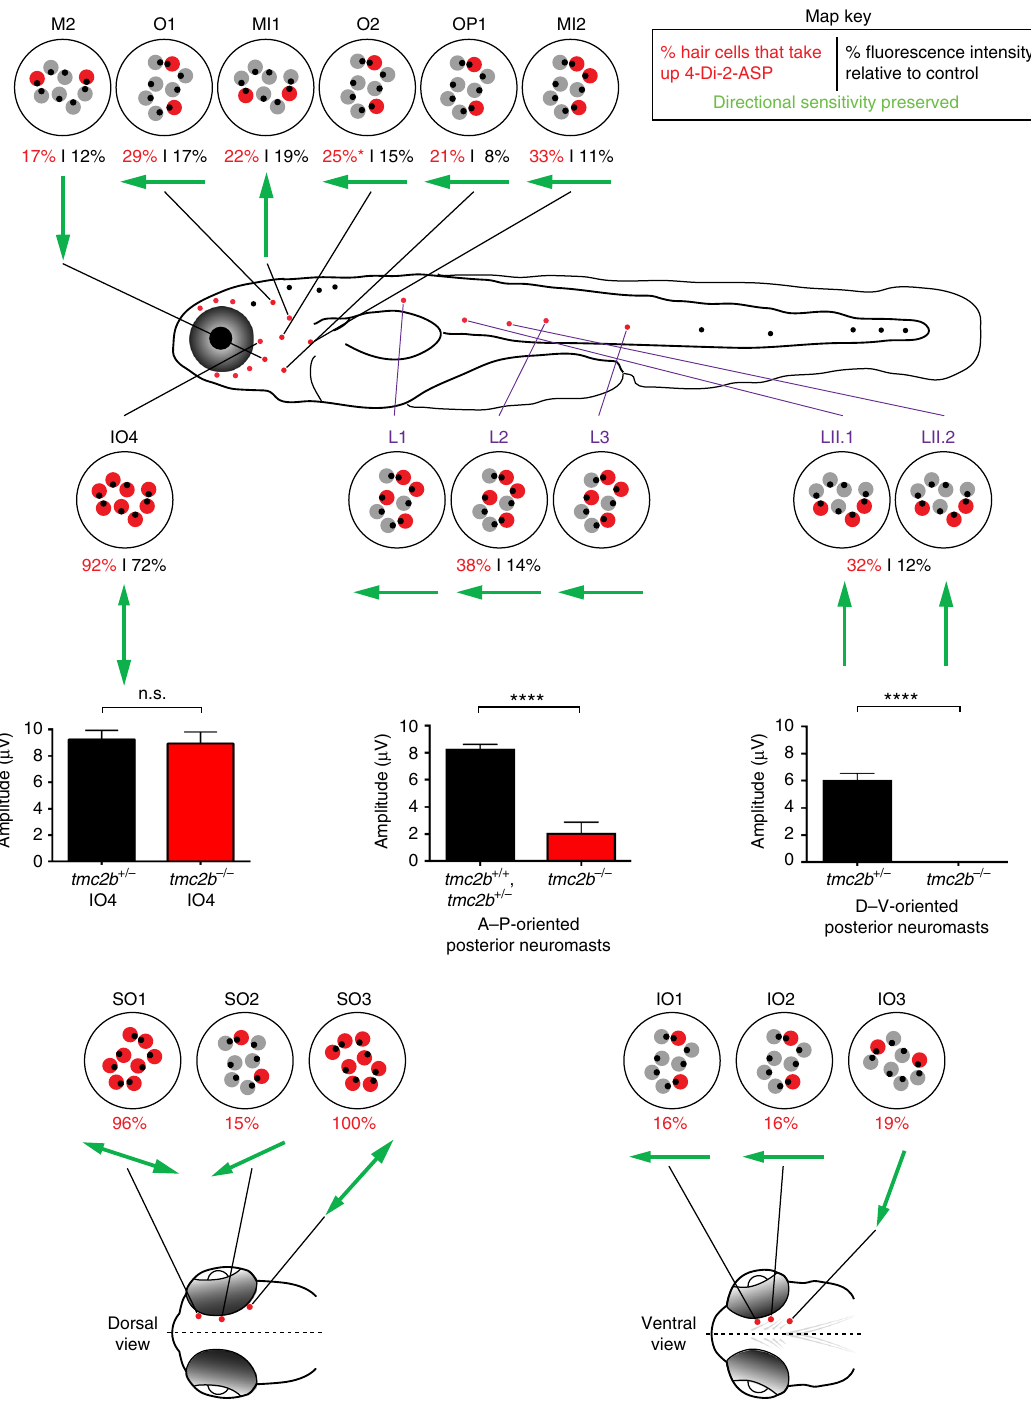
Fig. 6 A mechanosensory map of Tmc2b dependence in the anterior and posterior lateral lines. In this graphic of a larval zebra fi sh tmc2b − / − mutant, red neuromasts have been characterized. Individual neuromasts with patterns of FM1-43FX uptake are displayed. Red hair cells take up FM1-43FX; gray hair cells do not. Below each schematized neuromast is the percentage of hair cells that load 4-Di-2-ASP (red text) in the tmc2b − / − mutant and the percentage of fl uorescence intensity of hair cells of the mutant relative to hair cells of wild-type and heterozygous animals (black). Green arrows represent the directional sensitivity preserved in the mutant based on FM1-43FX uptake. Graphs of mean microphonic potentials from neuromasts directly above each plot are displayed. For IO4, tmc2b +/ − = 9.2 ± 0.7 μ V ( n = 9), and tmc2b − / − = 8.9 ± 0.87 μ V ( n = 6). P value = 0.9546. For A – P oriented